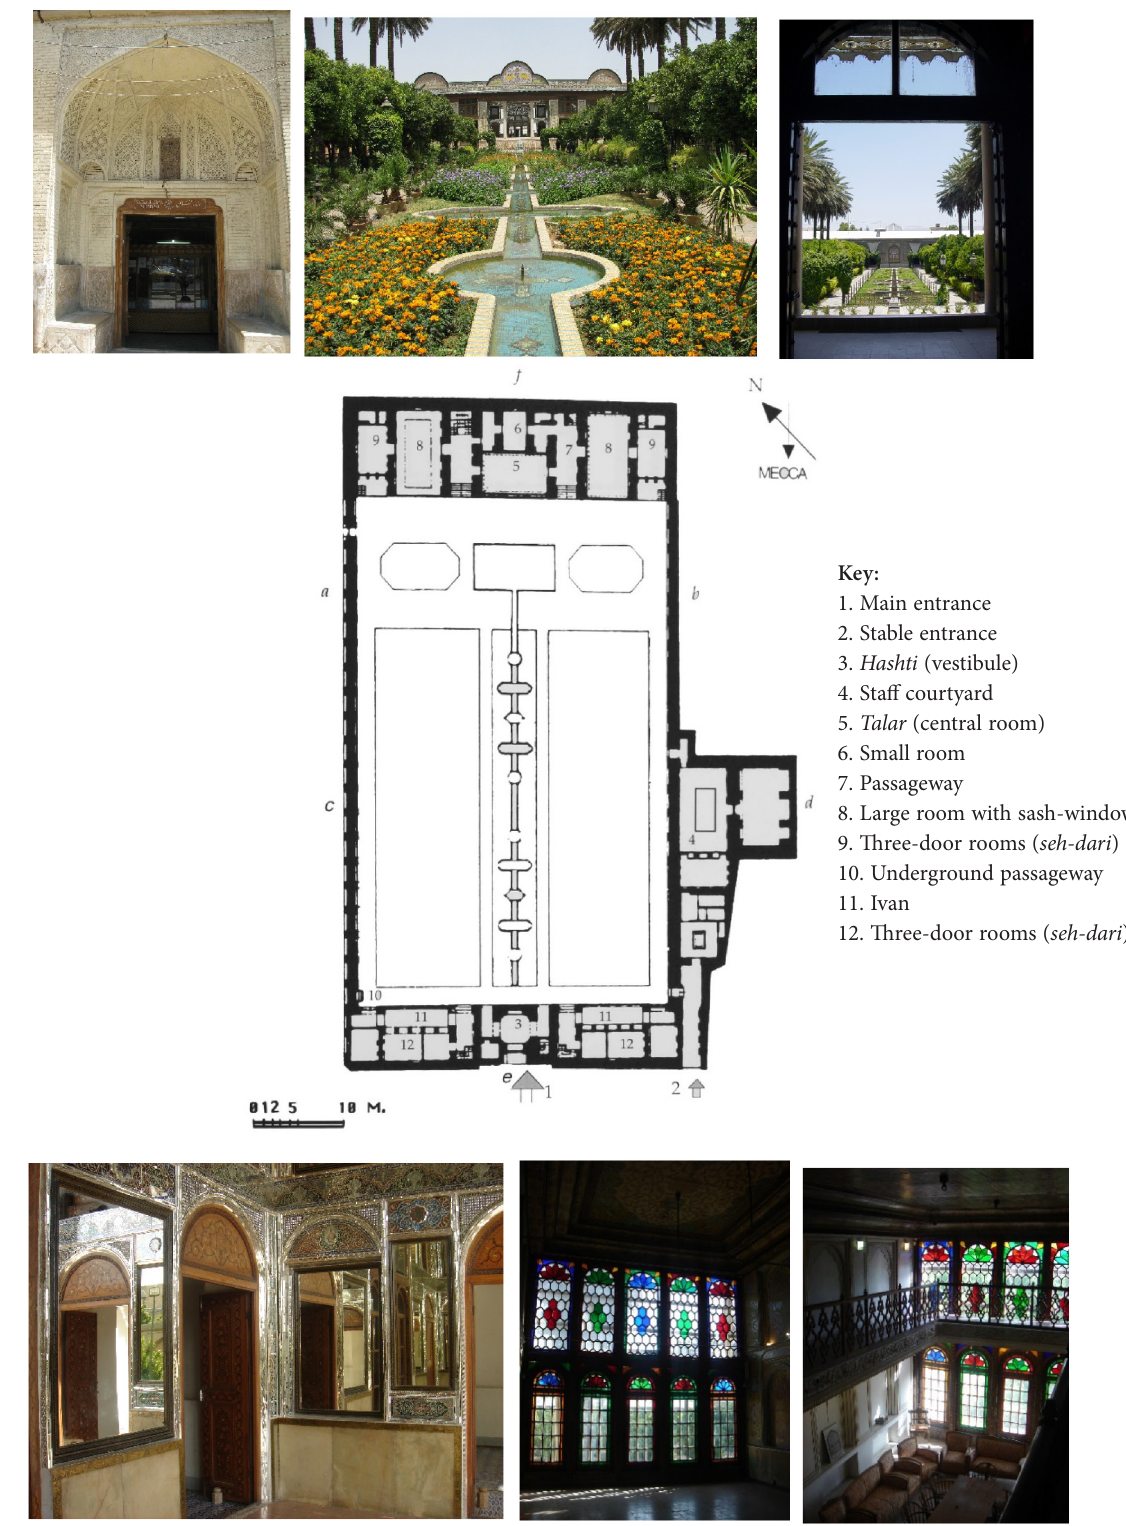
Figure 2. Ground floor plan of public domain of Qavam house (source: adopted from Memarian, 1998; source of photos Sara Mahdizadeh, summer